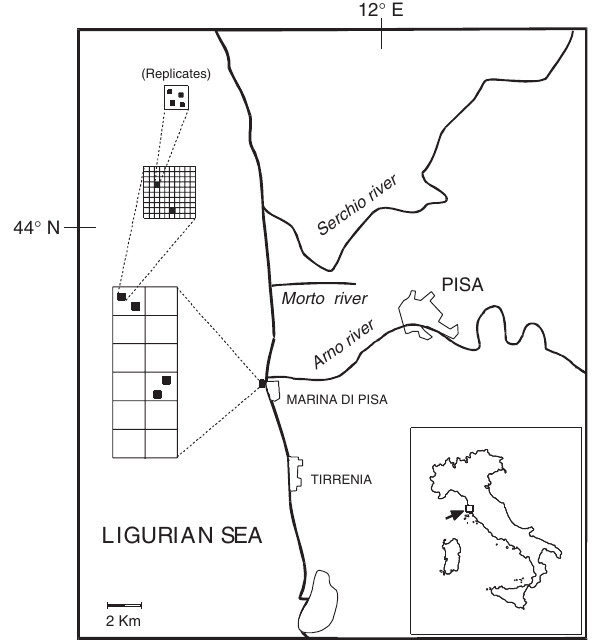
F IG . 1. – Map of the studied area, showing the sampling site (black rectangle) and the nested arrangement of the sampling